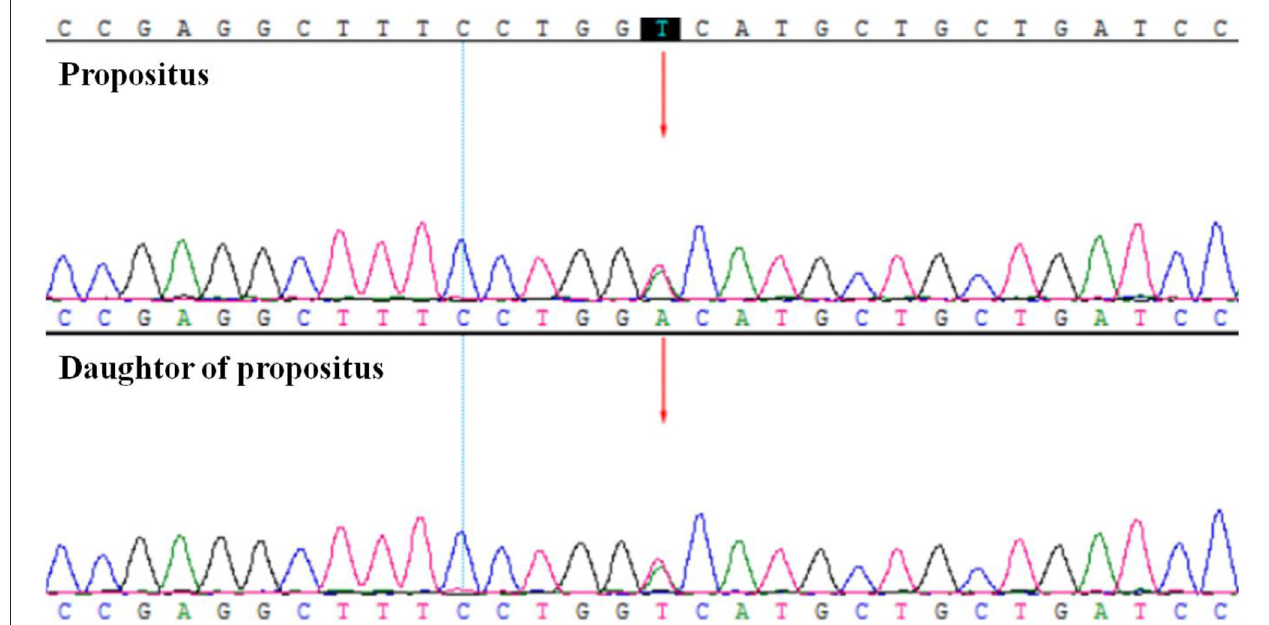
FIGURE 1 | The whole exome sequencing and Sanger sequencing verification showed the patient (propositus) and her daughter both had the heterozygous variant of PIEZO1 ; c.6017T > A; p.V2006D.